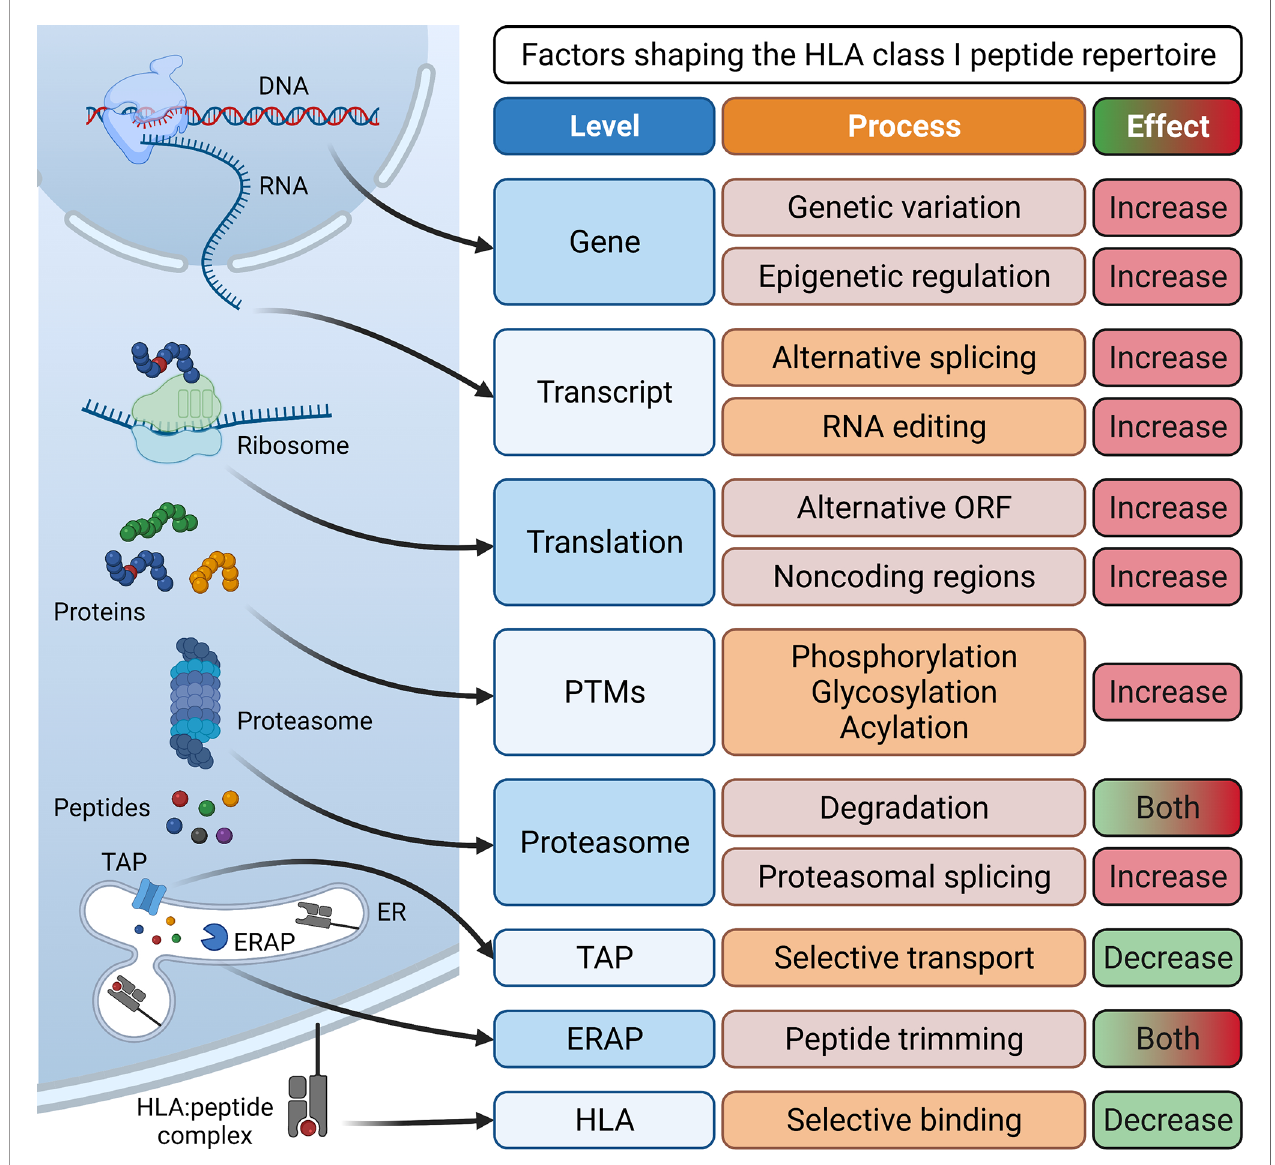
FIGURE 1 | Processes involved in antigen processing and presentation and their effect on the generation of a diverse HLA class I peptide repertoire. Peptides for surface presentation by HLA class I molecules are generated by transcription of DNA into mRNA and subsequent translation into proteins. Here, processes such as genetic variation and epigenetic regulation at the gene level, alternative splicing and RNA editing at the transcript level, the translation of alternative open reading frames (ORFs) and non-coding regions and post-transcriptional modi fi cations (PTMs) can enlarge the peptide repertoire. Eventually, proteins are degraded by the proteasome, generating peptides. Here, proteasomal splicing can increase peptide diversity while proteasomal degradation can also reduce the size of the repertoire by destroying some potential HLA binders. Finally, peptides are selectively conveyed via the transporter associated with antigen processing (TAP) into the lumen of the endoplasmic reticulum (ER). Here, some peptides are further trimmed by ER-associated aminopeptidases (ERAP) and then selectively associate with speci fi c human leukocyte antigen (HLA) complexes. Eventually, stable HLA:peptide complexes are transported to the cell surface for interaction with CD8 + T cells. Created with